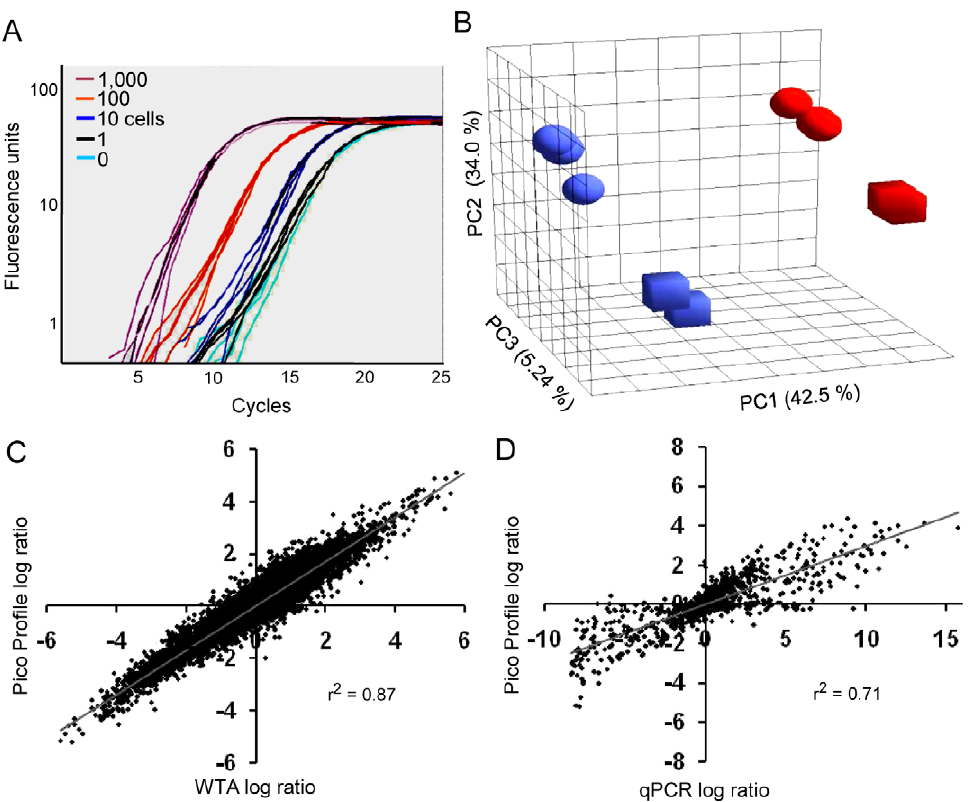
Figure 3. Evaluation of expression profiles from pg of RNA (Pico Profiling). A , SYBR Green amplification signals from 1,000, 100, 10, 1 and 0 cells. B , PCA of expression profiles of MAQC samples A (red) and B (blue) processed in triplicate starting from 25 ng RNA (cubes) and 100 pg (globes); the contribution of the specific component is shown next to its axis. C , correlation of differential expression between MAQC samples A and B measured from 25 ng and 100 pg RNA; average values of triplicates are displayed, all measurements of all probe sets are displayed. D , correlation of differential expression measured by Pico Profiling versus qPCR.